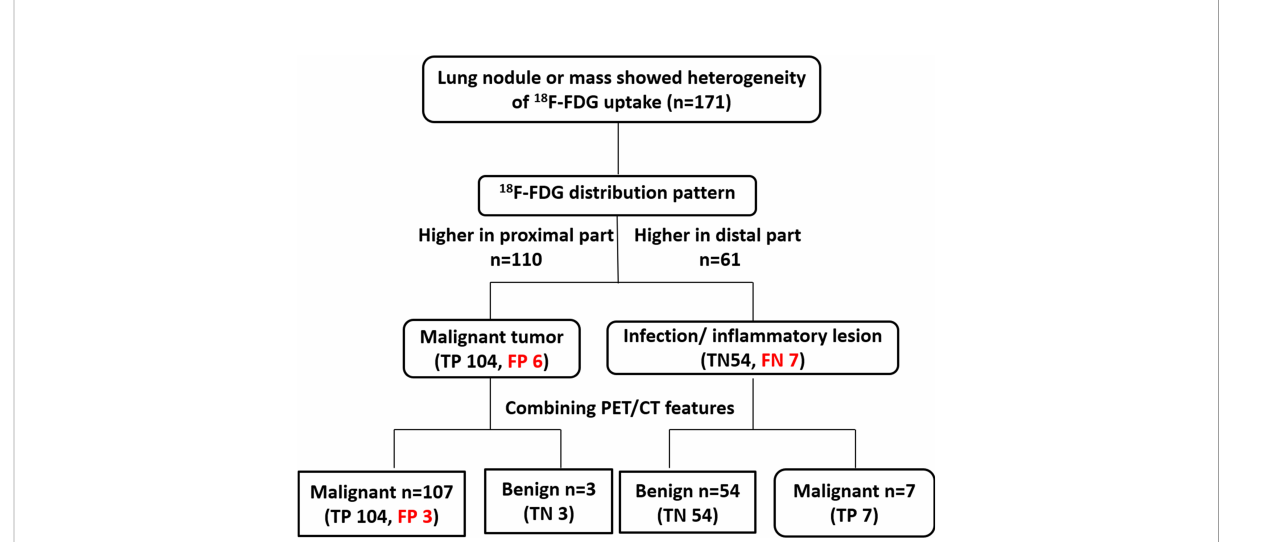
FIGURE 7 The proposed diagnostic chart fl ow. The lesions in 110 patients showed higher metabolism in the proximal end than in the distal end, and were initially judged to be malignant. Lesions in 61 patients showed higher distal metabolism than proximal and were thus judged to be benign. After all the lesions were further combined with PET/CT features, 3 of the malignant lesions were fi nally corrected to be benign, and the other 3 were still misdiagnosed as malignant. All 7 benign lesions were reclassi fi ed as malignant lesions. Based on the diagnostic chart fl ow, the diagnostic accuracy reached to